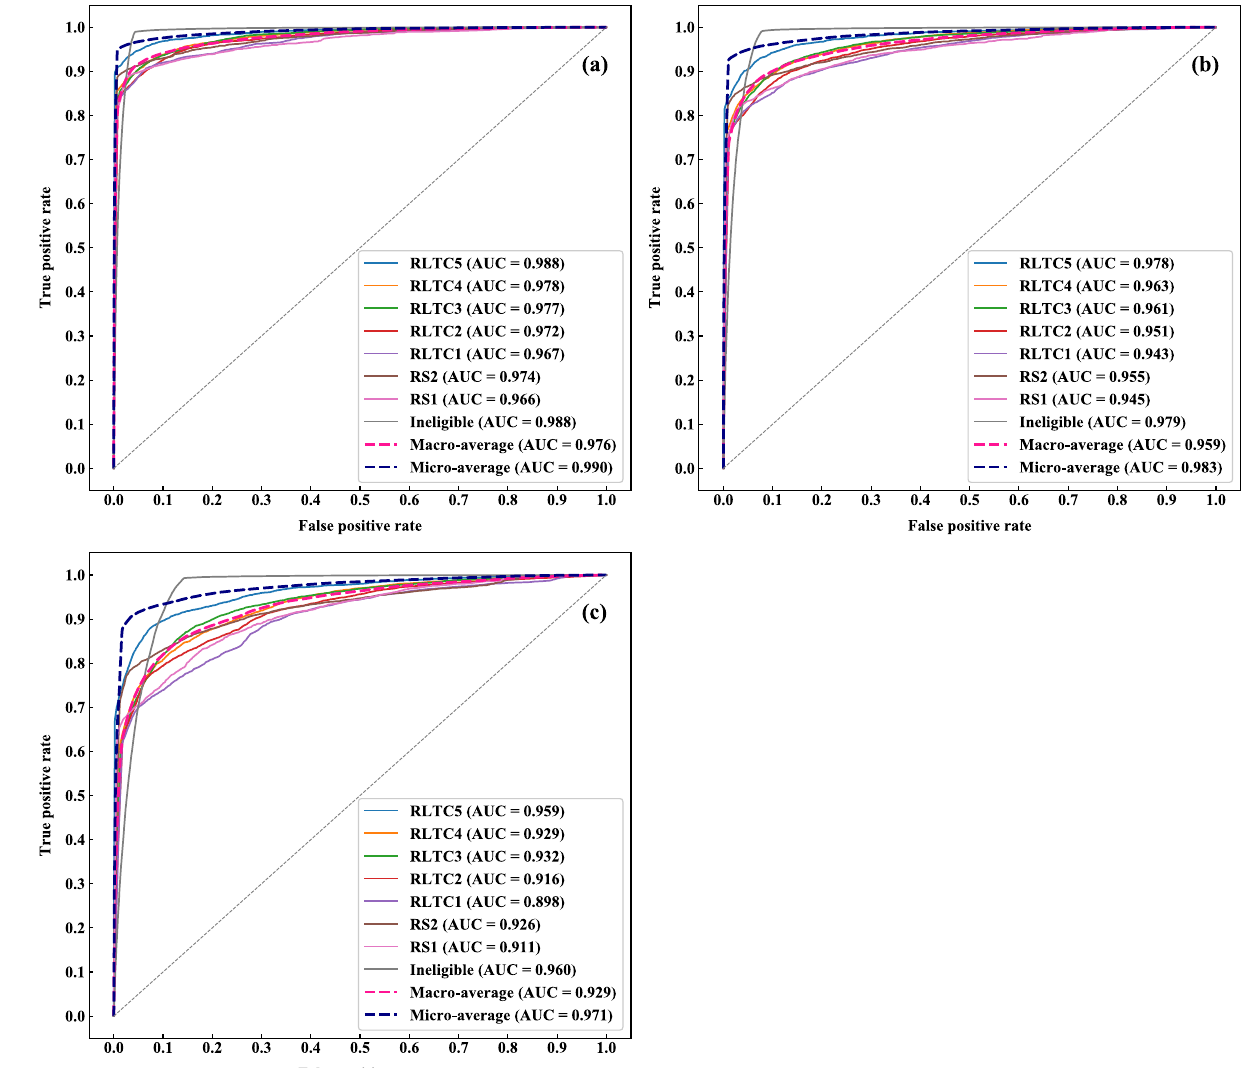
Fig. 2 ROC curves and AUC values in the future eligibility level